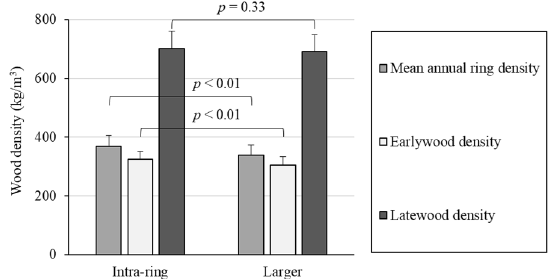
Fig. 9 Comparison of annual ring density in logs with intra-ring radial cracks and larger radial